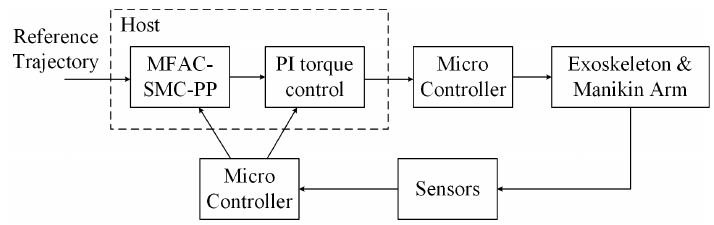
Figure 12. Block diagram of the experimental